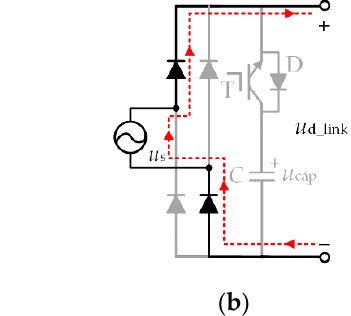
Figure 1. Topology of a brushless DC motor (BLDCM) drive system with a small DC-link capacitor.